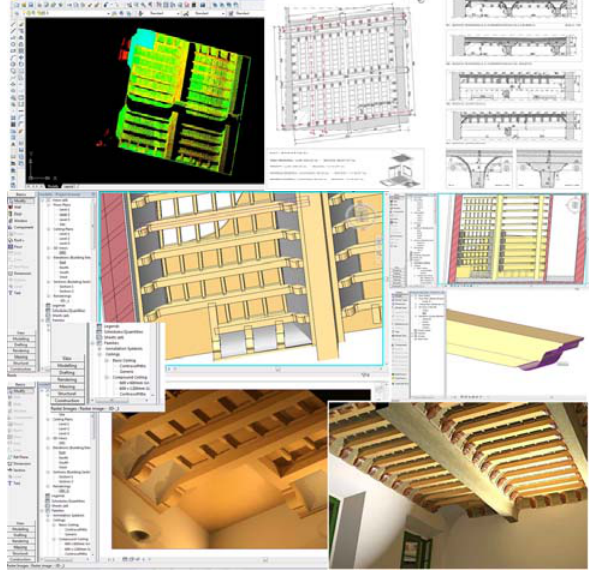
Figure 5. HBIM (© Autodesk Revit) of wooden vault in Soldi Palace in Cremona (Italy): 3D elements modelling process using laser scanner point clouds and hands on